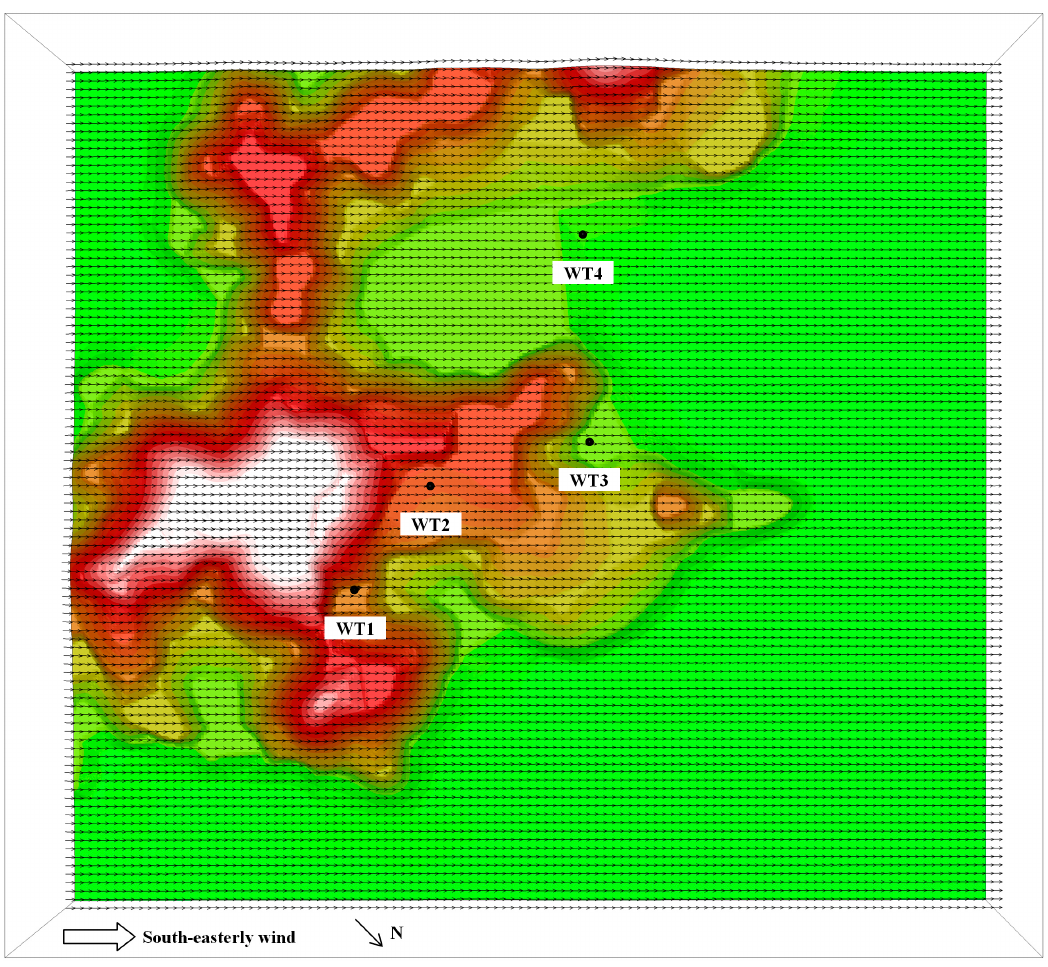
Figure 8. Wind velocity vectors at the wind turbine hub-height (78 m), time-averaged field. The averaging time period is 100 to 200 in non-dimensional time (see Figure 10).